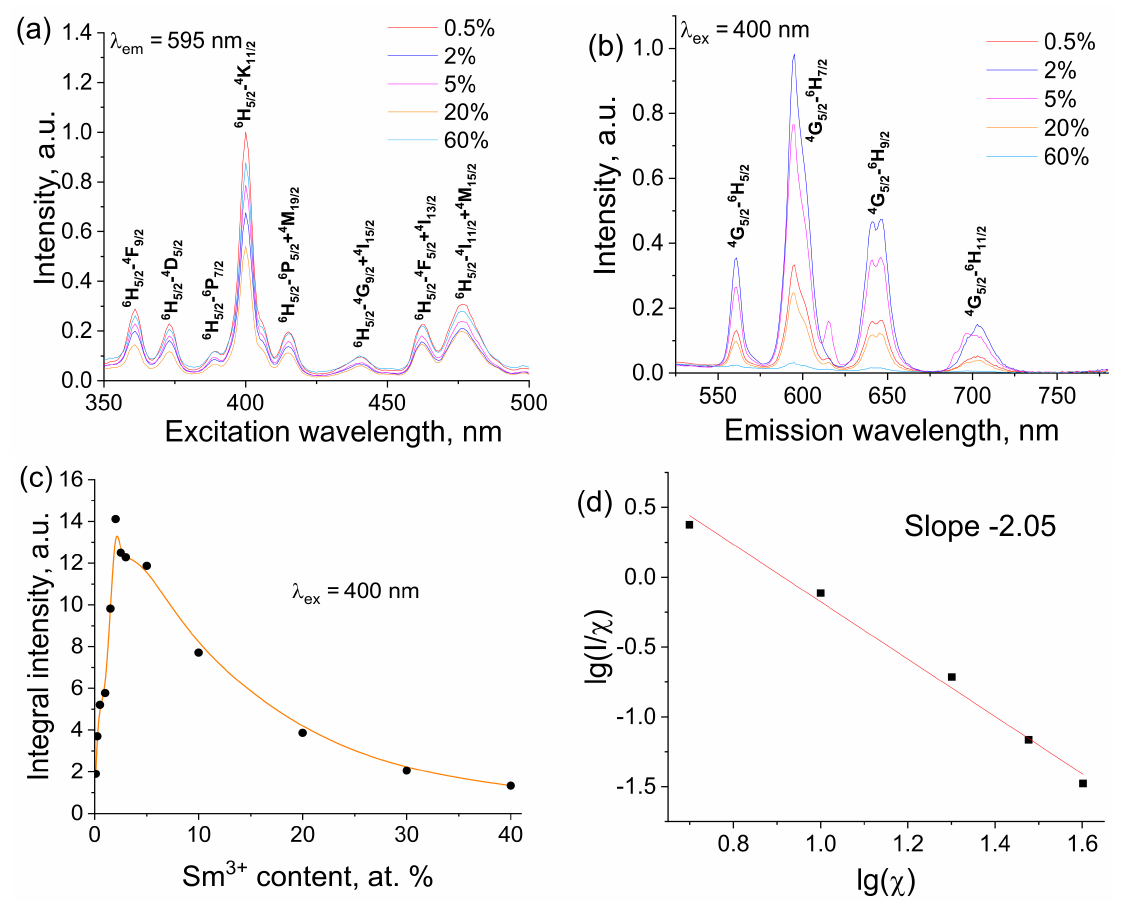
Figure 8. The luminescence excitation ( a ) emission ( b ) spectra of NaY 1-x Sm x F 4 concentration series; dependence of integral intensities of 5 G 5/2 → 6 H 7/2 emission band on Sm 3+ concentration ( c ), logarithmic plot NaY 1 − x Sm x F 4 of emission integral intensity dependence on dopant concentration fitted to the linear function ( d ).